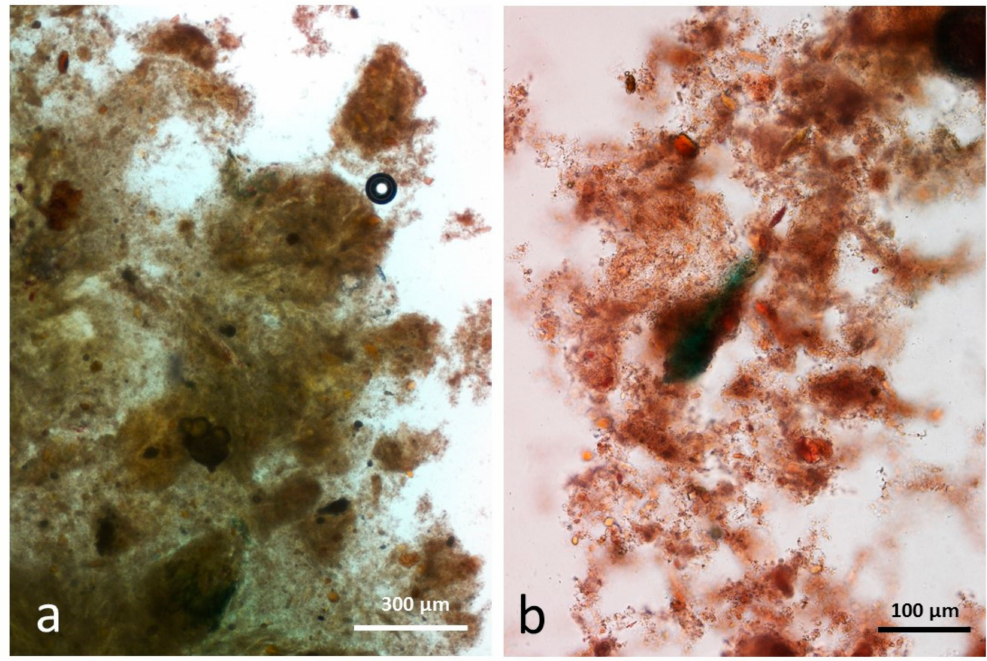
Figure 9. Faecal sample stained with Sudan IV from control diet, no almonds eaten, ( a , b ) faeces contain plant remains in a background of micro-organisms and